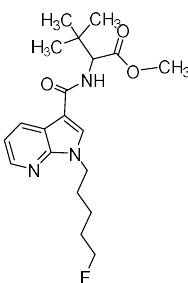
Figure 1. Chemical structure of 7′ N -5F-ADB.